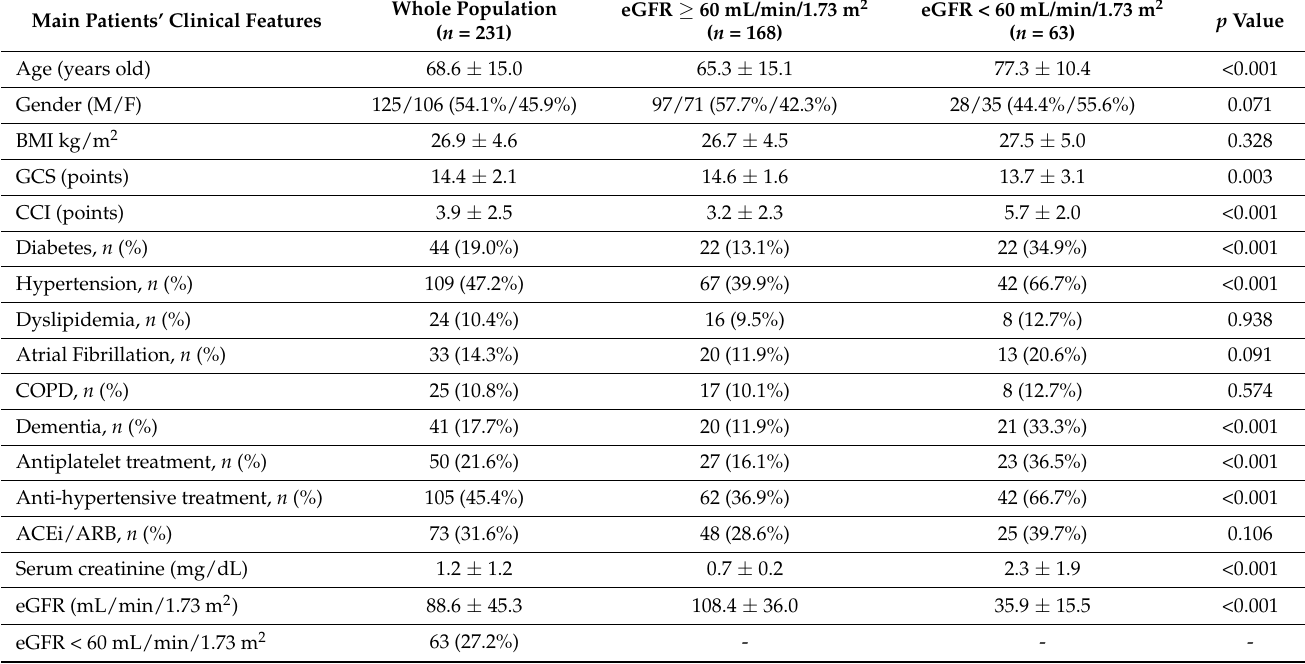
Table 1. Main clinical features of the 231 patients included in the study, as a whole population and divided according to eGFR categories (below/equal or above 60 mL/min/1.73 m 2